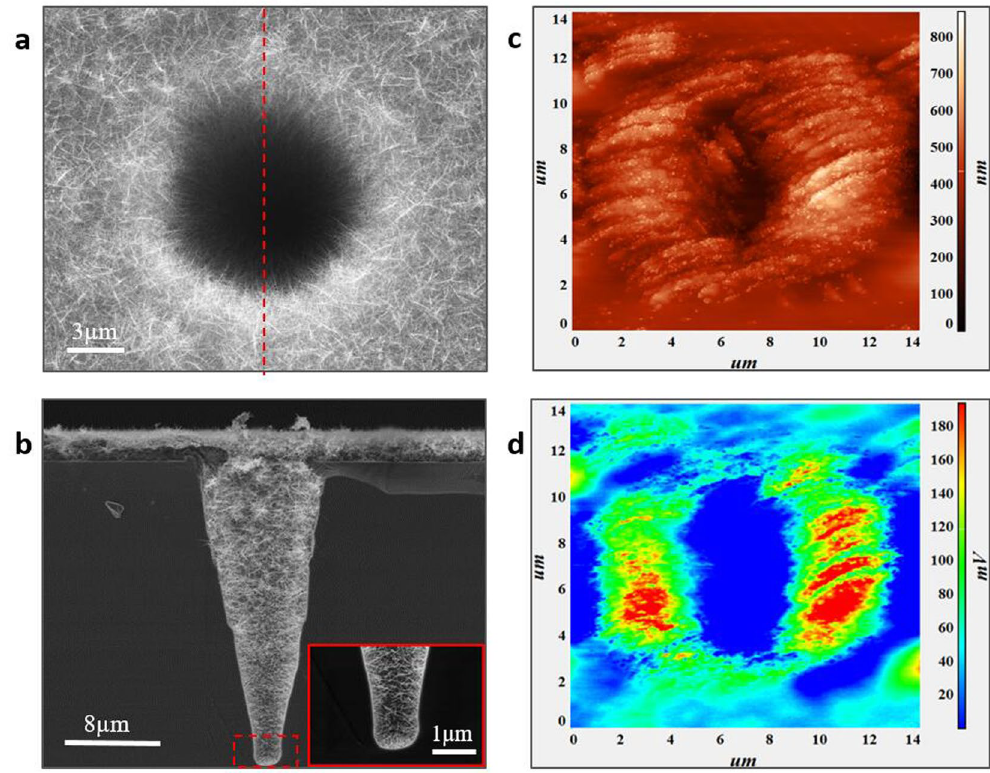
Figure 3. Morphology and electric field distribution of deep V-pits covered by ITO nanowire networks. ( a ) Single hole was covered by ITO nanowire networks completely. ( b ) All the inner-wall of the hole was covered by ITO nanowire networks, and the insert is the large image of bottom area. ( c ) The AFM image (measured by Contact Topography Mode) and ( d ) the electric field distribution of V-pits covered by nanowires were measured by SNOM through applying 10 V to the probe